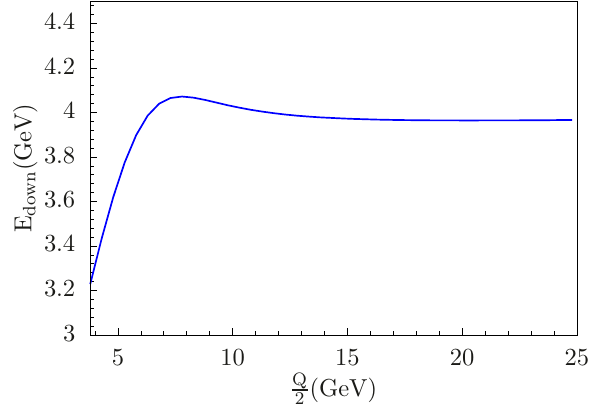
Figure 5 . The ratios of pQCD and NRQCD results, ^ k ( i ) = ^ f for 3 S [1] and (4.29), at CM energies 10, 30, and 100 GeV.